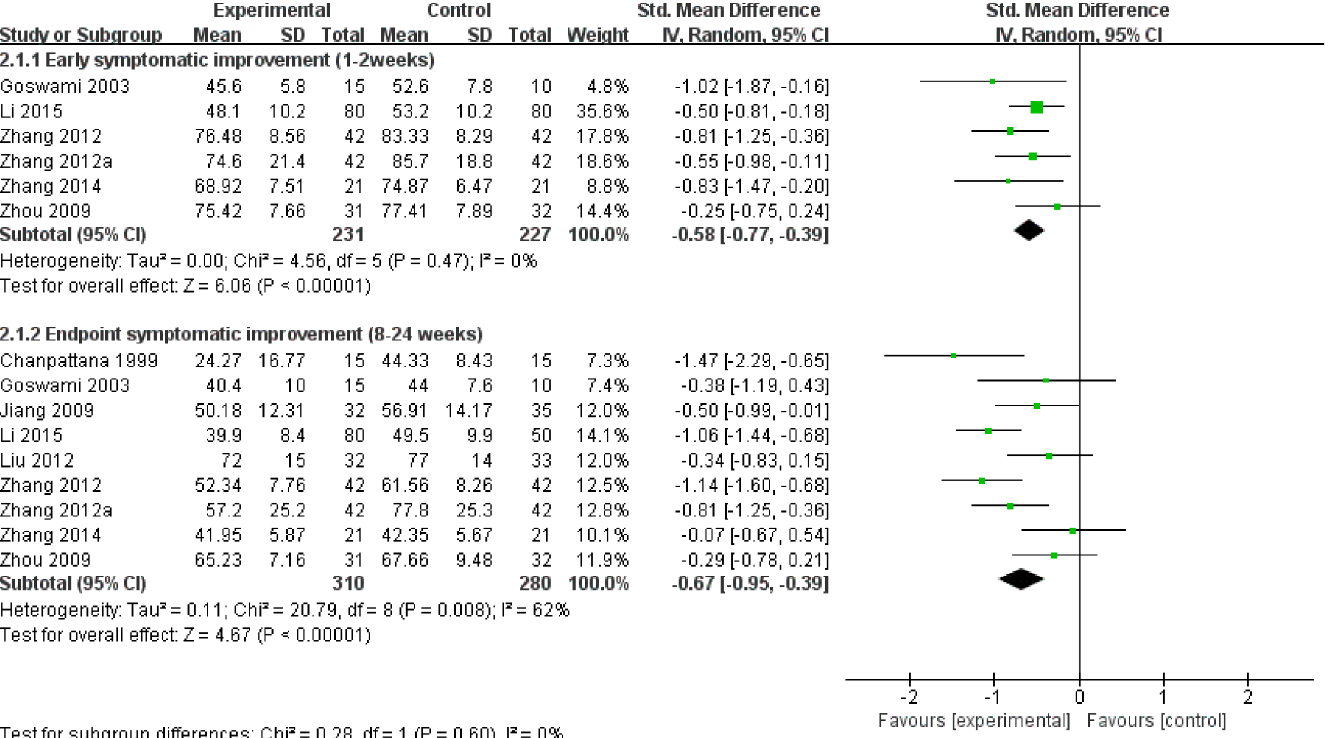
Fig 2. ECT added to non-clozapine antipsychotic medications for treatment-resistant schizophrenia: improvement in total psychopathology at 1 – 2 weeks and study endpoint.